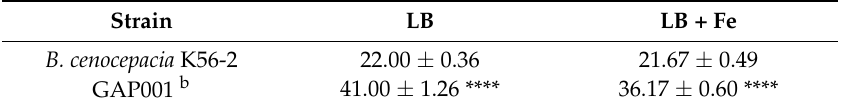
Table 2. CAS a assay halos (mm).